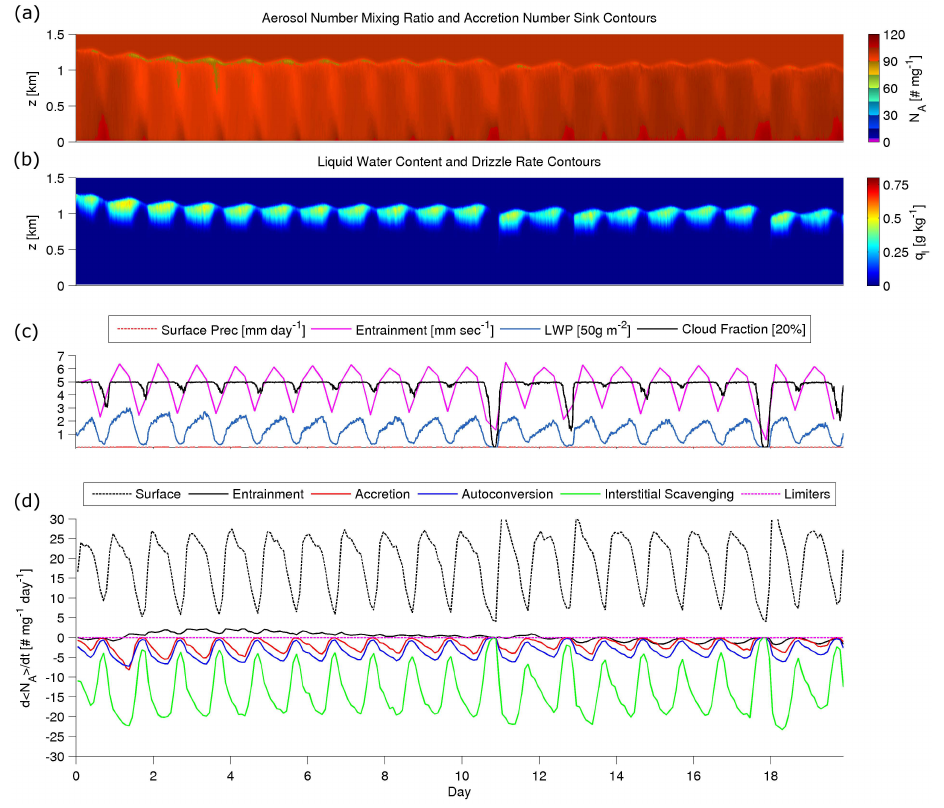
Fig. 9. Time-height plots and time series for run W6.5/NA100/DC. Panels as in Fig.